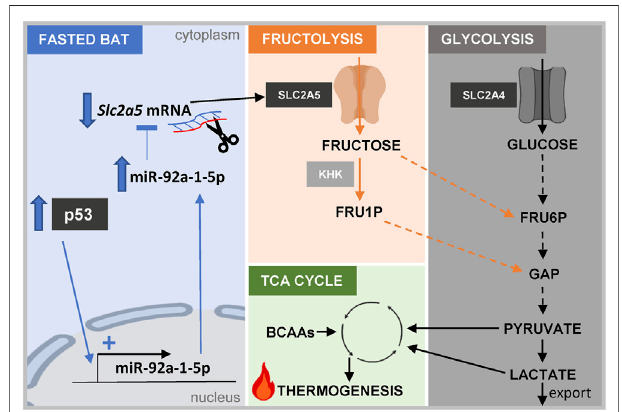
FIGURE 7 | Graphical abstract. Scheme depicting the proposed connection between the p53/miR-92a-1-5p/Slc2a5 axis, fructose and glucose metabolism, and thermogenesis in brown adipocytes. Abbreviations: KHK, keto-hexokinase; FRU1P, fructose-1-phosphate; FRU6P, fructose-6-phosphate;GAP, glyceraldehye-3-phosphate; BCAAs, branched- chain amino acids.